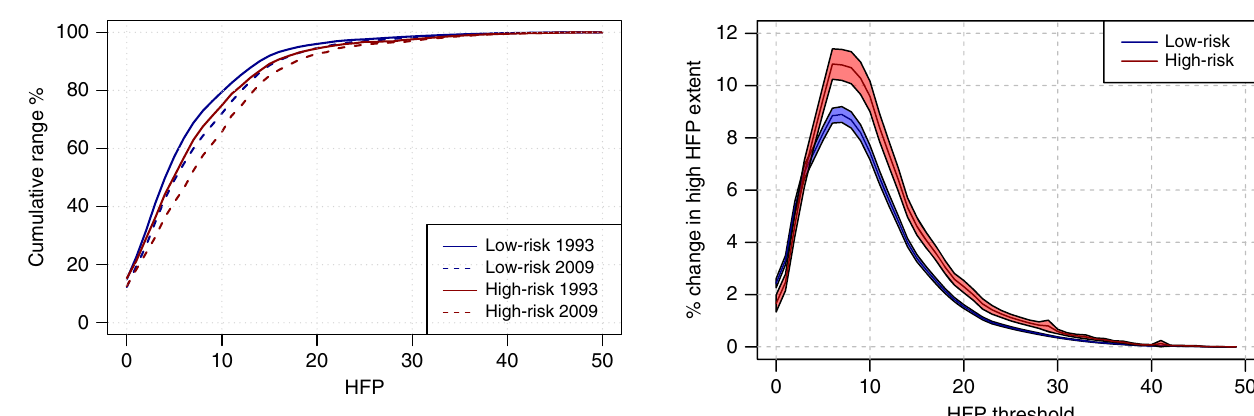
Fig. 3 Cumulative extent of human footprint values within mammal species ranges. The lines represent the cumulative percentage of species range that overlaps with increasing values of human footprint, averaged among all species. Different lines refer to species in the low-risk or high-risk categories, for the period 1993 or 2009, as reported in legend